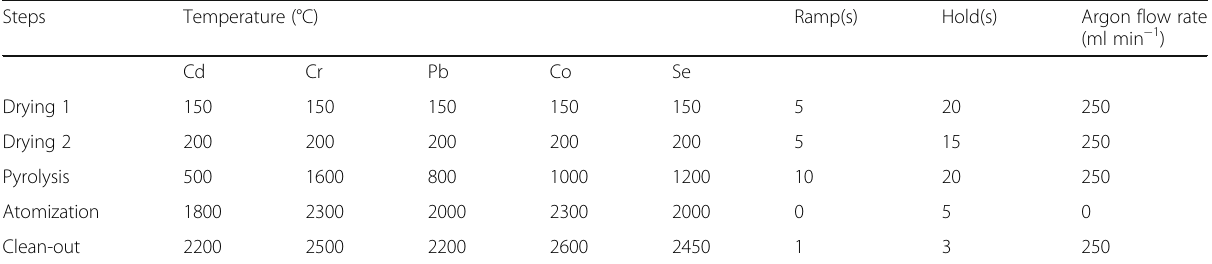
Table 3 Programs of heating method for chromium (Cr), cadmium (Cd), cobalt (Co), lead (Pb), and selenium (Se) in graphite furnace atomic absorption spectrophotometer (GFAAS)